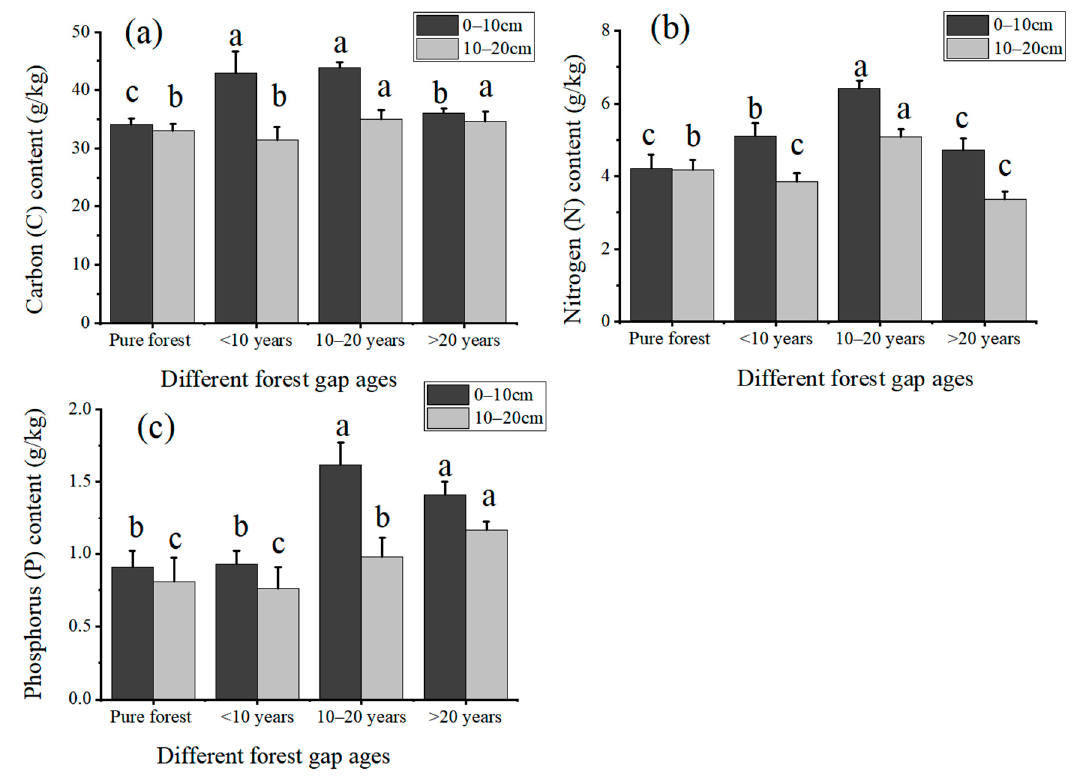
Figure 2. Variations of C content ( a ), N content ( b ), and P content ( c ) in different forest gap ages. Note: Different letters indicate significant differences between different forest gap ages in the same soil layer ( p < 0.05). Error bars represent ±standard errors.